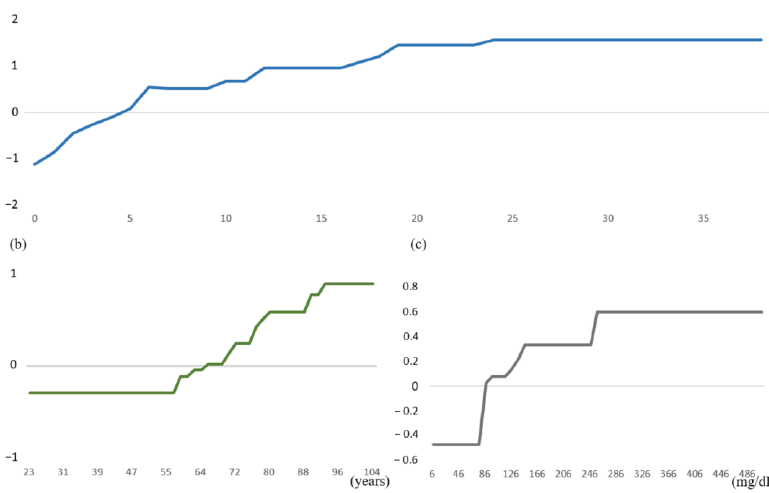
Figure 4. Partial dependence plot of variables. The x -axis represents the value of a particular variable; values on the y -axis indicate the risk of developing an unfavorable outcome. A positive value indicates that a higher variable value increases the risk of an unfavorable outcome. (a)NIHSS. (b) Age. (c) Fasting glucose.